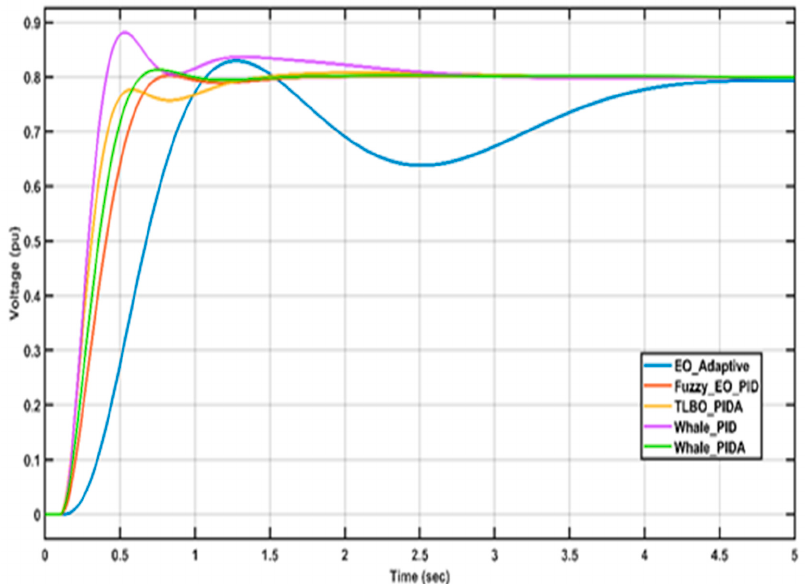
Figure 9. Focusing on the 1 pu step voltage reference case.